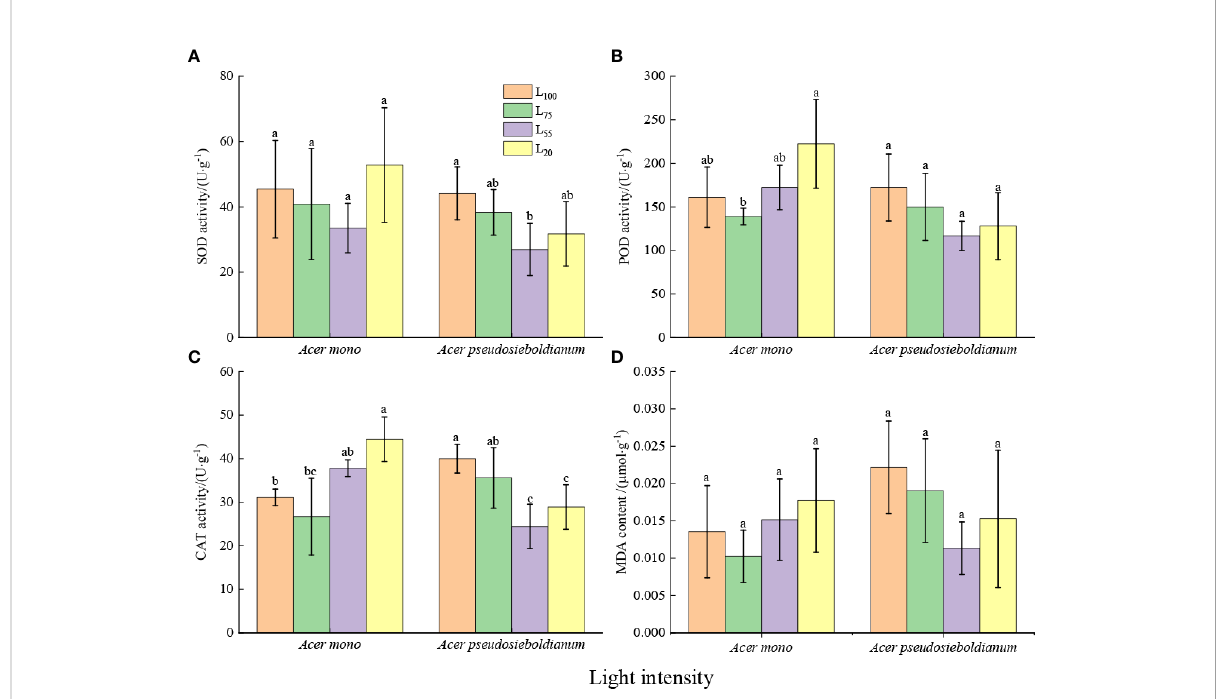
FIGURE 2 Effect of light intensity on leaf antioxidant enzymes ( A , SOD; B , POD; C , CAT) and MDA (D) . Small letters indicate signi fi cant differences under different light intensities ( P <